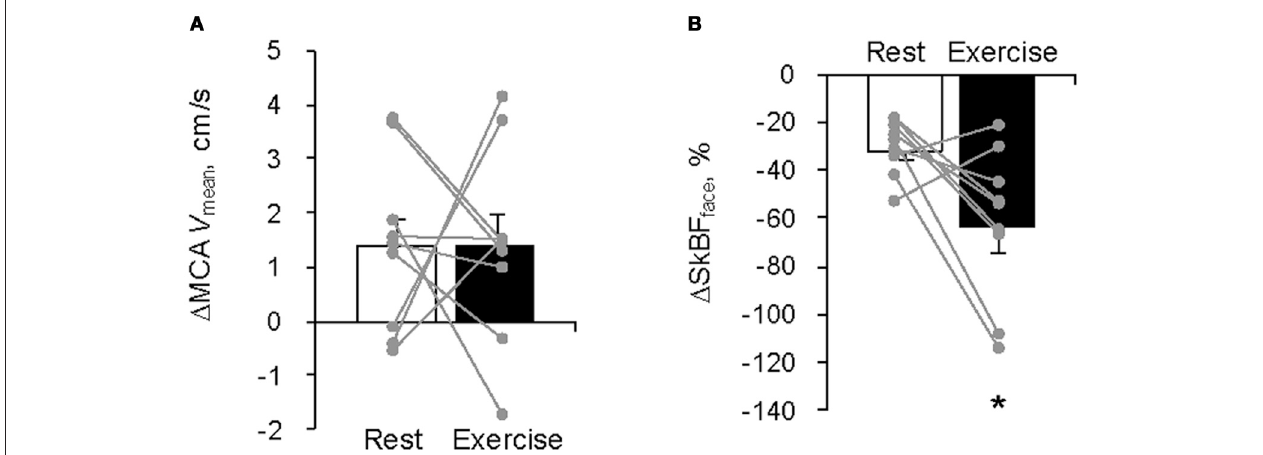
FIGURE 2 | Facial cooling-induced hemodynamicchanges ( (cid:2) ) at rest and during exercise: (A) middle cerebral artery mean blood velocity (MCA V mean ) and (B) forehead skin blood flow (SkBF face ). Each gray plot represents an individual response. Values are means ± S.E.M. ∗ P < 0 . 05 different from rest.